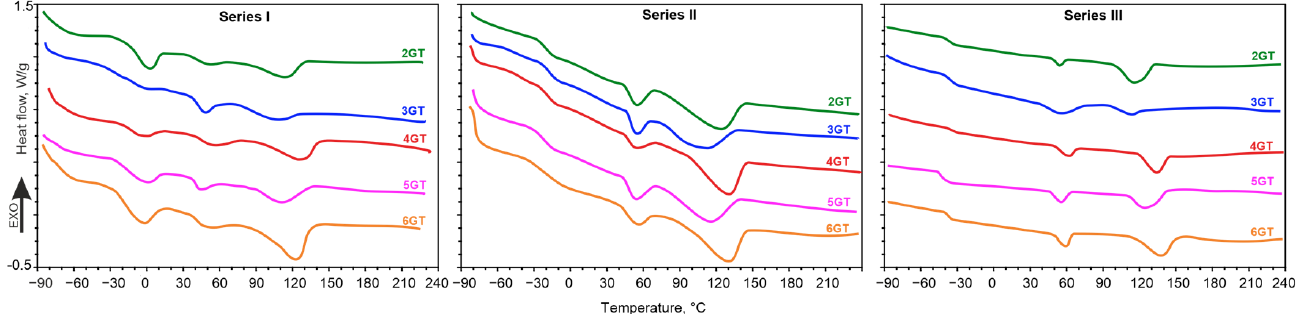
Figure 9. Differential Scanning Calorimetry (DSC) second heating curves of the obtained terpolymers.